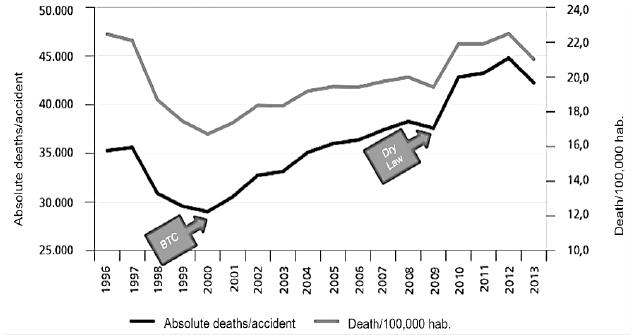
Fig. 1. Evolution of mortality from terrestrial transport